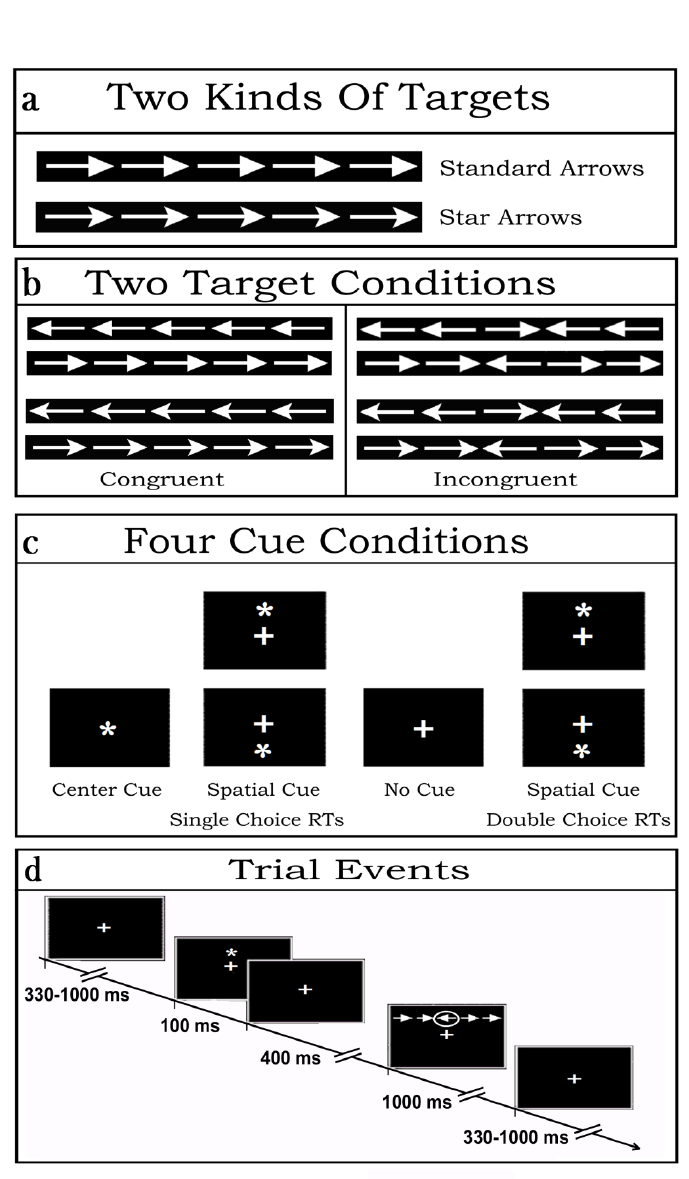
Figure 1. Graphical depiction of the stimulus materials, of cue-target conditions, and of trial events used in the present study (ANT-SR (Attention Network Test-Slightly Redesigned); modified and redrawn from Fan et al. [40] and Posner [44]). ( a ) Two kinds of white arrow-target strings were presented: “standard” and “star” arrows. ( b ) Congruent and incongruent central targets vs. flanker strings were presented. Based on the direction of the arrow tip (left or right), eight target-flanker conditions resulted. ( c ) Four di ff erent cue-target and motor-task experimental conditions were administered in randomized order: a no cue (NC) condition; a center, alerting but spatially unpredictable cue (Central Cue, CC), and a valid spatially informative cue (Local Cue, LC). In these three conditions, participants’ motor response to targets depended on a single-choice reaction time (RT) button-press. In a fourth cueing condition, LCmot, volunteers had to discriminate both the target-arrow type and orientation in order to make a double-choice RTs button-press. ( d ) Schematic exemplification of cue–target stimulus-events and inter-stimulus interval (ISI) duration during a single trial of the LC condition as well as of the random inter-trial interval (ITI) length. See text for further